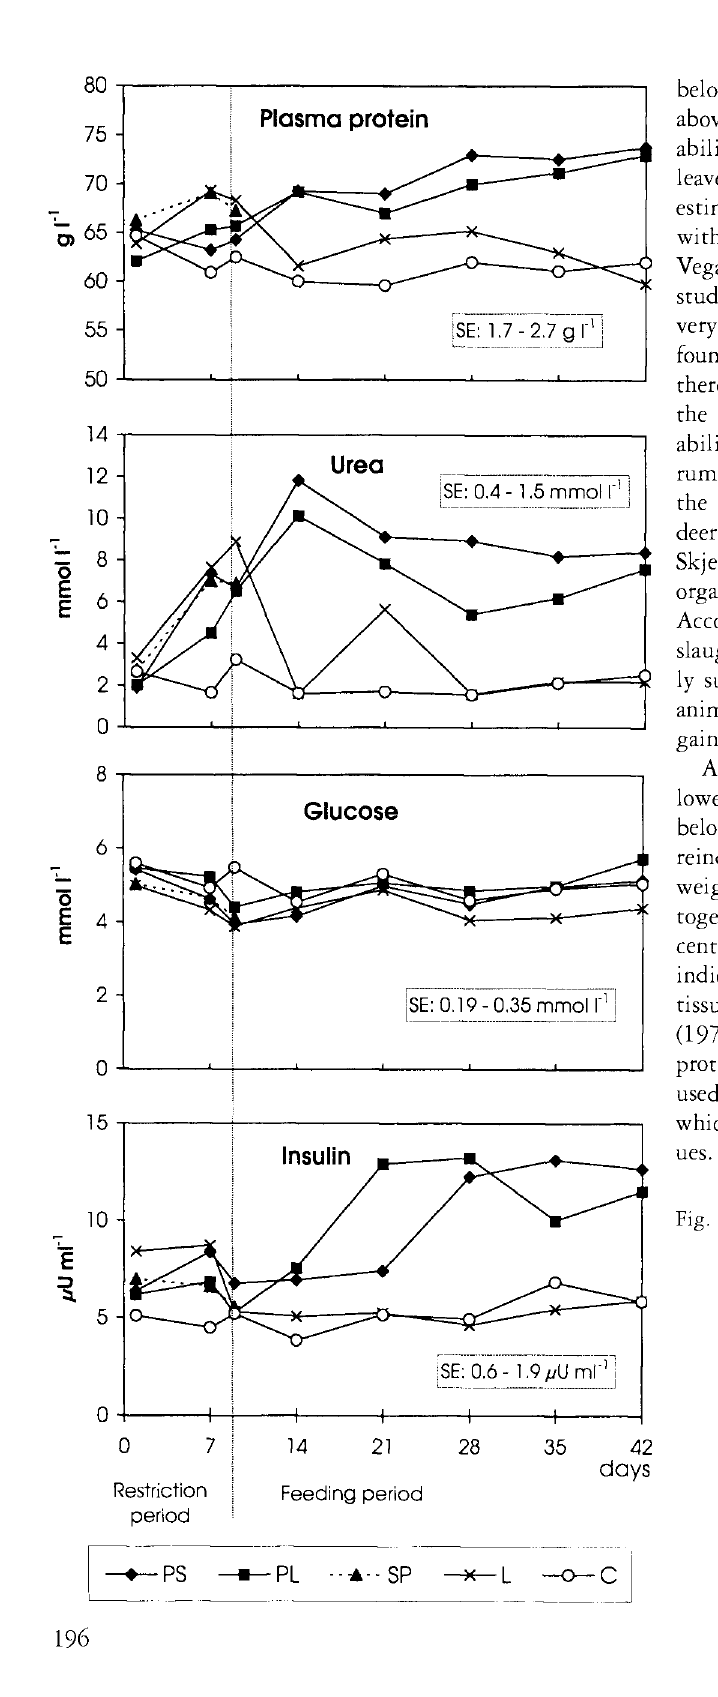
Fig. 3. Protein, urea, glucose and insulin con centrations in blood plasma (least square means for five reindeer per group) dur ing the restriction period, when controls (group C) were fed a lichen-based diet ad lib. and rhe other groups were fed a restricted amount of the same diet, and during the feeding period, when group C and L were fed the lichen diet ad lib. and group PS and PL were fed pellets combined with silage and lichens, respectively. Group SP was excluded after the restriction period, due to loss of animals. The ranges of standard errors are shown in the